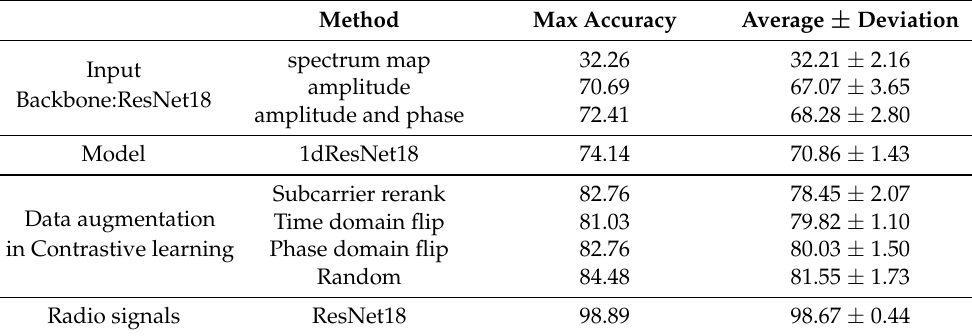
Table 2. OFDM signals and radio signals identification max accuracy and average accuracy. We show the effectiveness of our proposed method by gradually adding proposed modules. Radio signals is different from OFDM signals, which has only one carriers without knowing the modulation type.